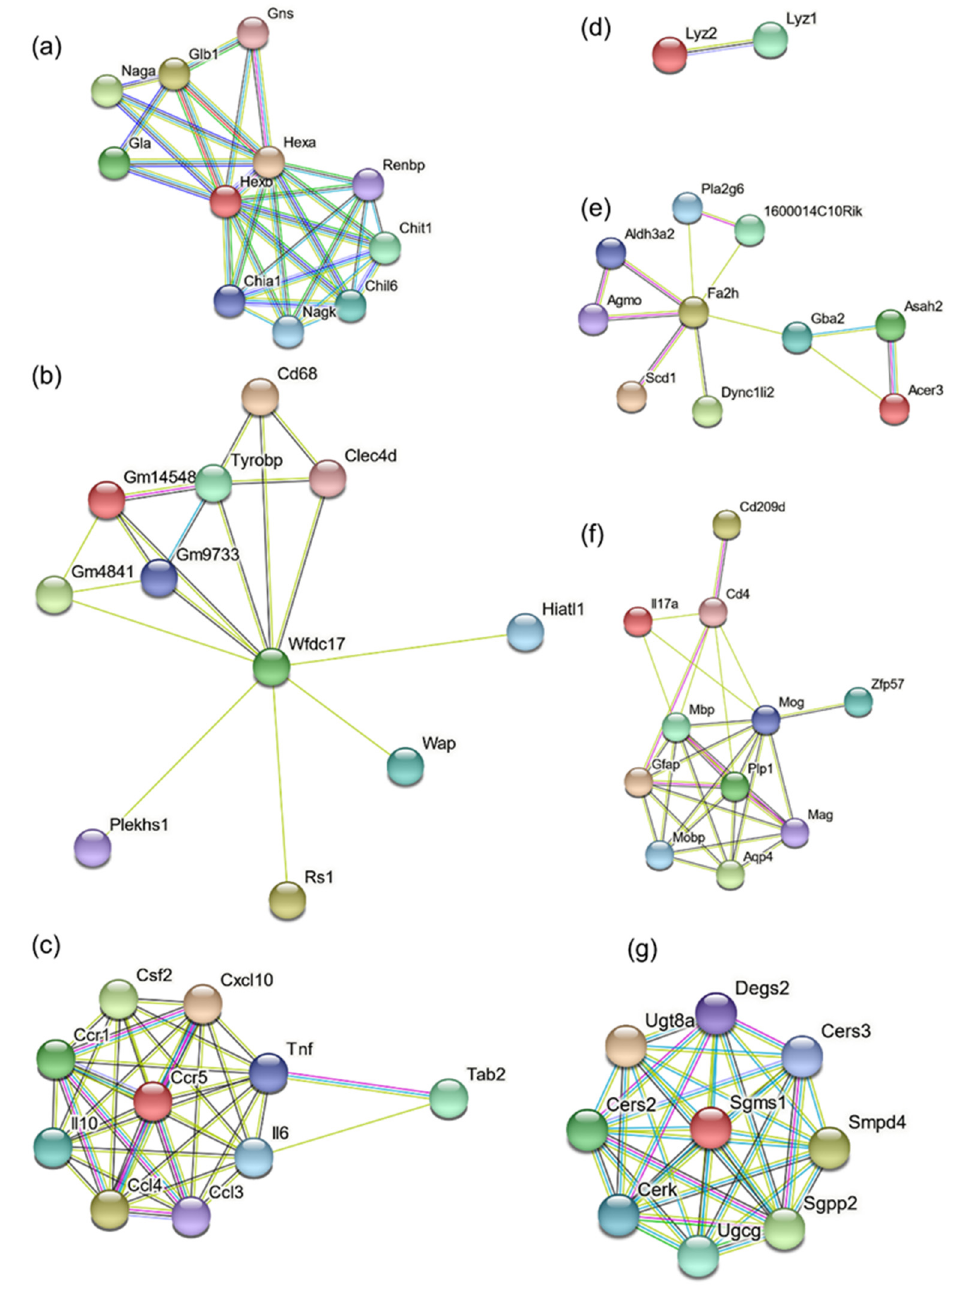
Figure 6. Functional protein association network clusters for ( a ) Hexb , ( b ) Wfdc17 , ( c ) CCl3 , ( d ) Lyz2 , ( e ) Fa2h , ( f ) Mog , and ( g ) Ugt8a. Table 2. Functional annotation of HexB protein association network.